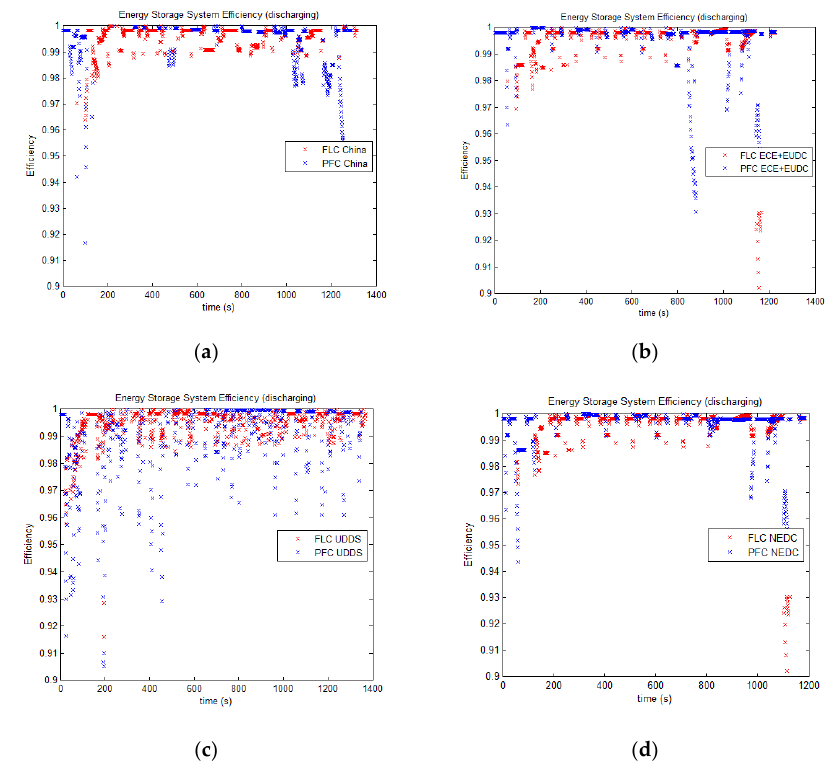
Figure 6. Energy storage system efficiency of discharging: ( a ) China, ( b ) ECE+EUDC, ( c )UDDS, and ( d ) NEDC.